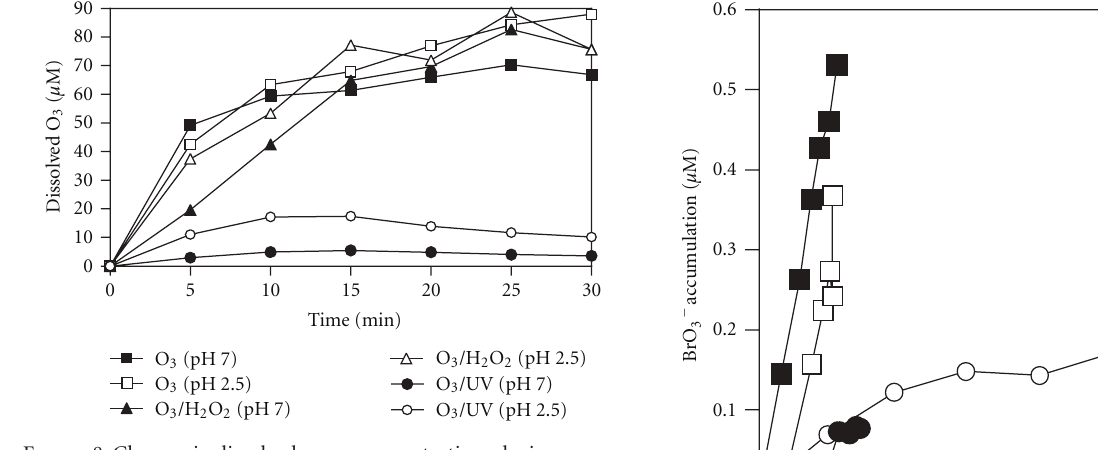
Figure 8: Changes in dissolved ozone concentrations during ozona- tion, O 3 /H 2 O 2 (the H 2 O 2 dose of 100 µ M), and O 3 /UV with the addition of 4-CBA.